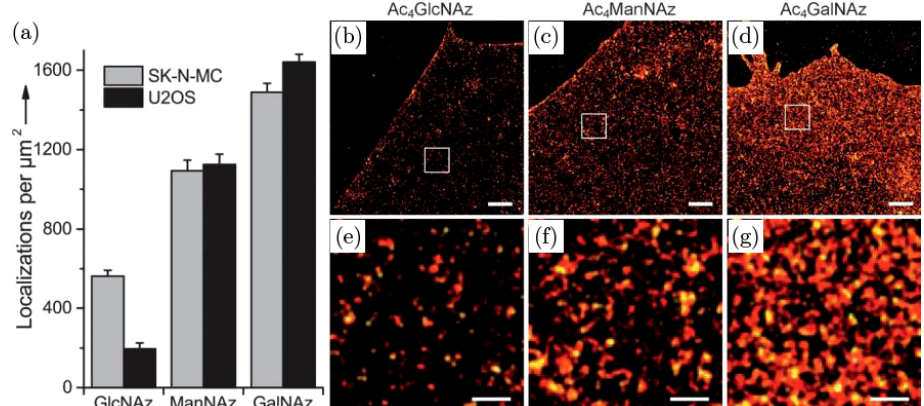
Fig. 7. Super-resolution imaging and analysis of cell-surface glycoproteins containing Sia or GlcNAc. Combination of click chemistry and dSTORM imaging to visualize and analyze the carbohydrates on SK-N-MC neuroblastoma cells and U2OS cells fed with one of the reactive azido sugars (Ac 4 GlcNAz, Ac 4 ManNAz, or Ac 4 GalNAz). (a) Localization density of membrane-associated carbohydrates labeled with Alexa 647 (20 (cid:1) M). Error bars are the standard error of the mean of 12 – 32 imaged cells. (b) – (d), dSTORM images of glycoconjugates in the basal membrane of SK-N-MC neuroblastoma cells. (e) – (g), Enlarged images of white boxed regions. Scale bars are 1 (cid:1) m (b) – (d) and 200 nm (e) – (g). Adapted with permission from Ref.